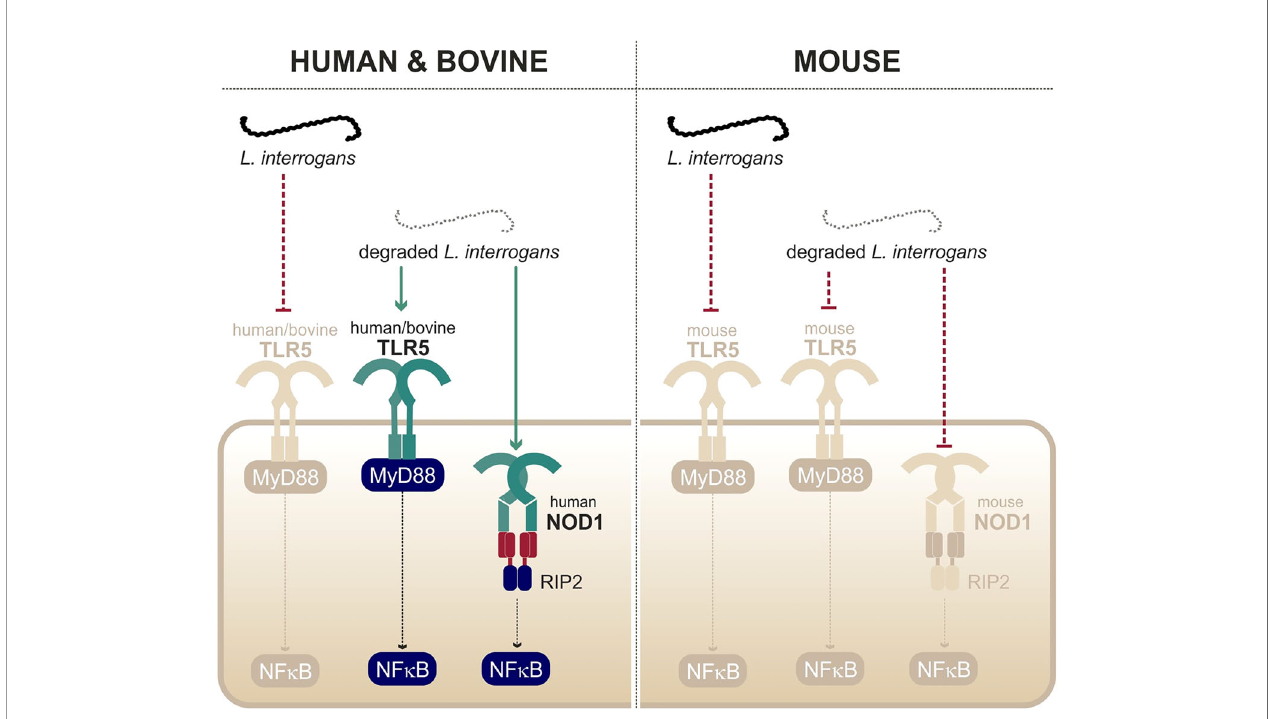
FIGURE 5 | Recognition of degraded leptospires only by human/bovine TLR5 and human NOD1. Adapted from Ratet et al. (2017) and Holzapfel et al.